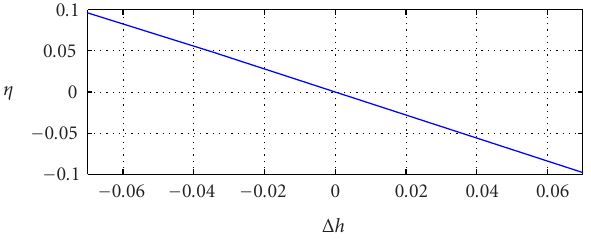
Figure 7: Term η for L = 3, independent of the modulation index o ff set.